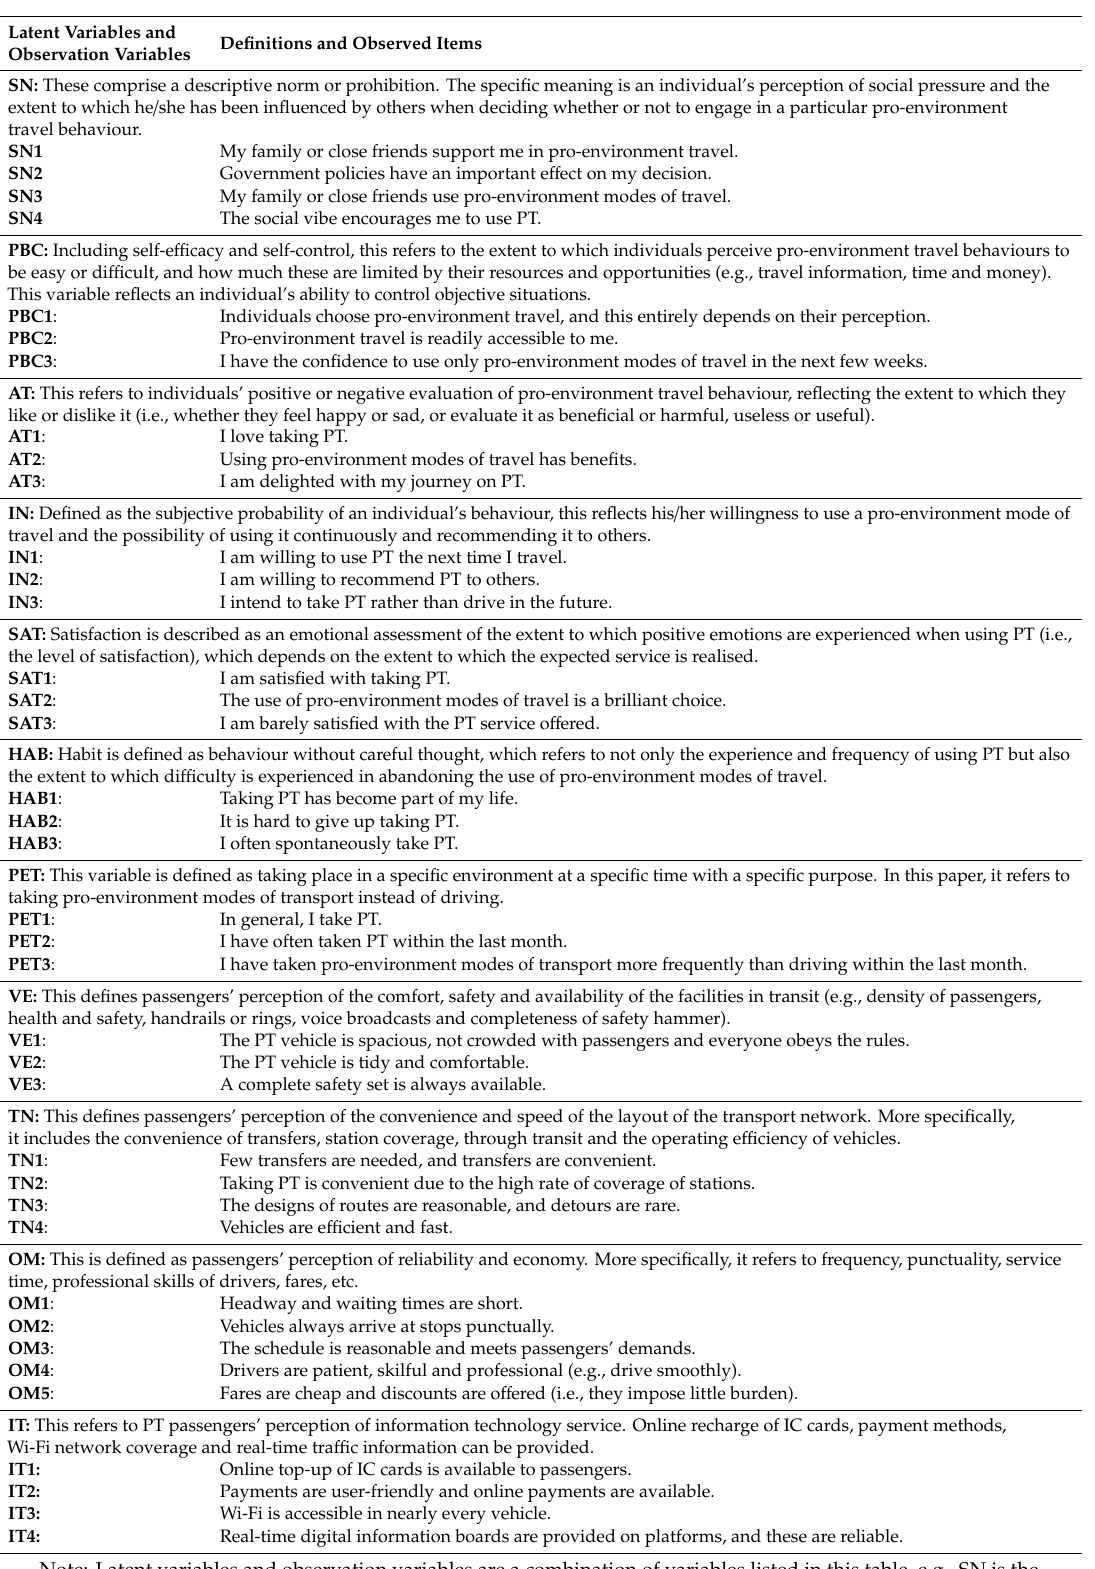
Table A2. Variables, definitions and observed